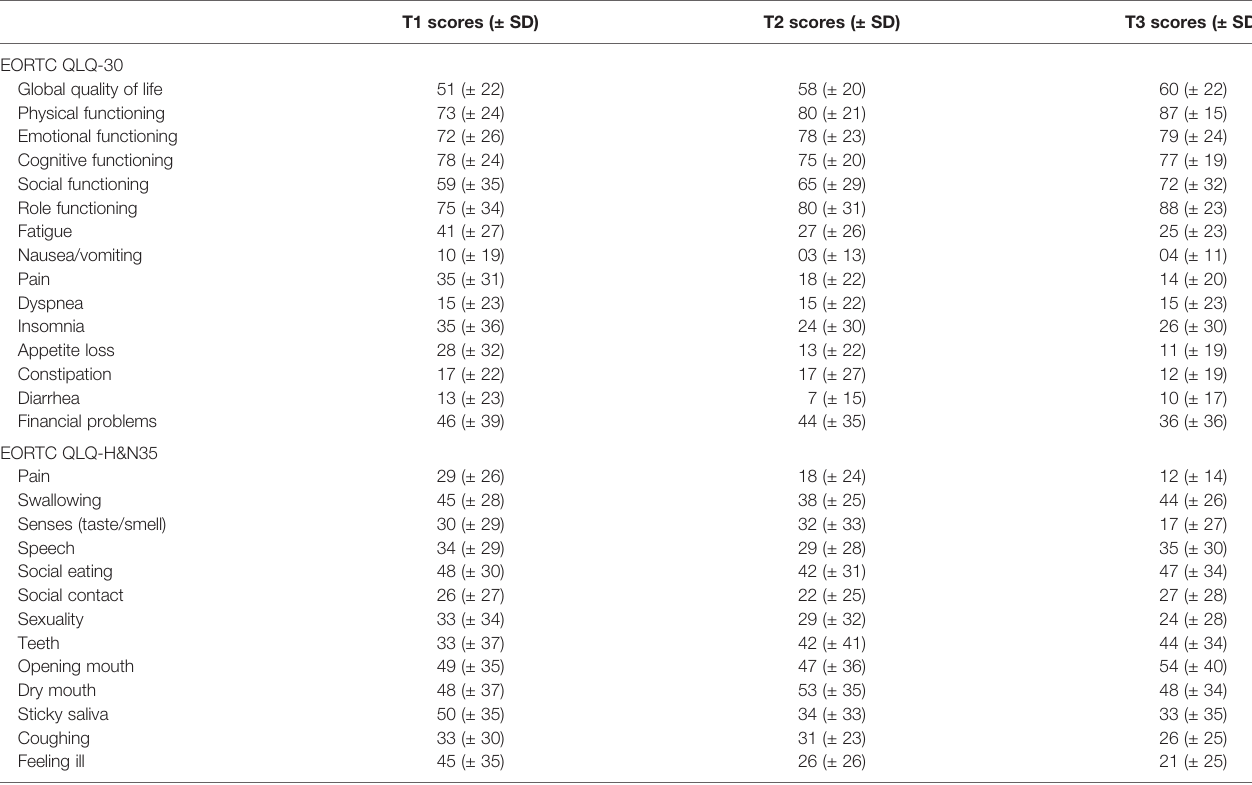
TABLE 2 | The mean scores of the EORTC QOL scales in different periods of time.